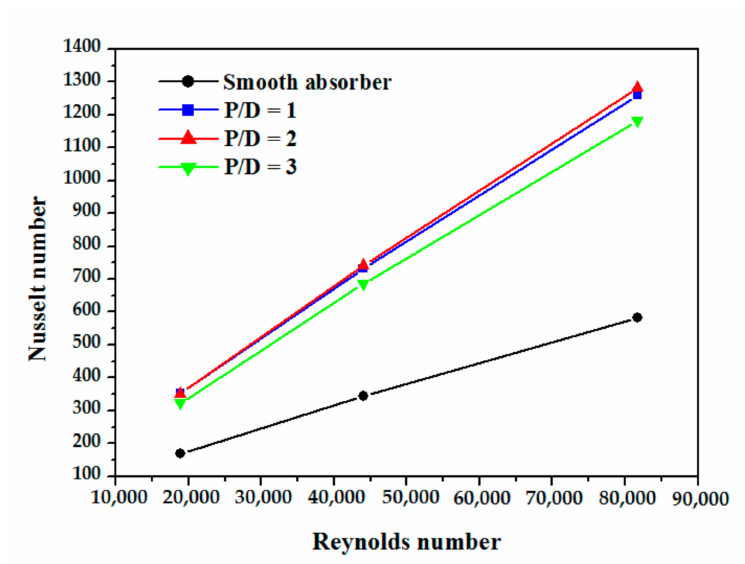
Figure 11. Nusselt number variation vs. Re number at different obstacle spacing.